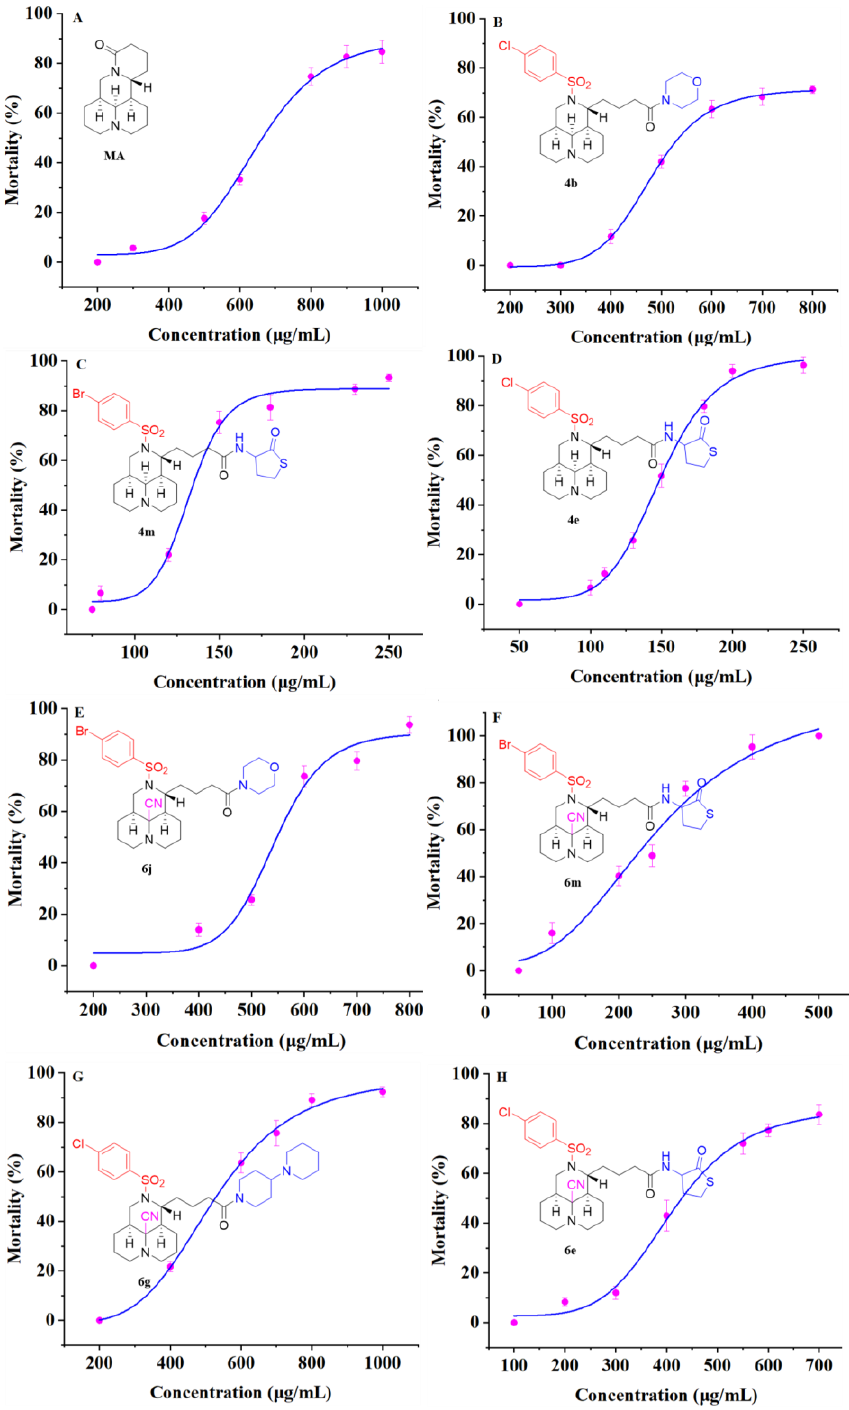
Figure 1. The dose – response curves on larvae of Ae. albopictus : ( A ) MA ; ( B ) 4b ; ( C ) 4m ; ( D ) 4e ; ( E ) 6j ; ( F ) 6m ; ( G ) 6g ; ( H ) 6e .